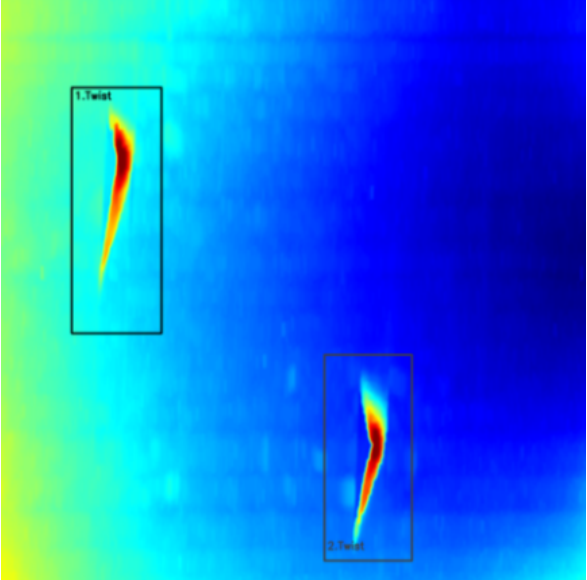
Figure 5: Two twist defects upon a fiber layup colorized in false colours, © DLR